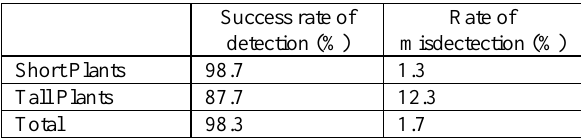
Table 4. Results of flooding extent mapping